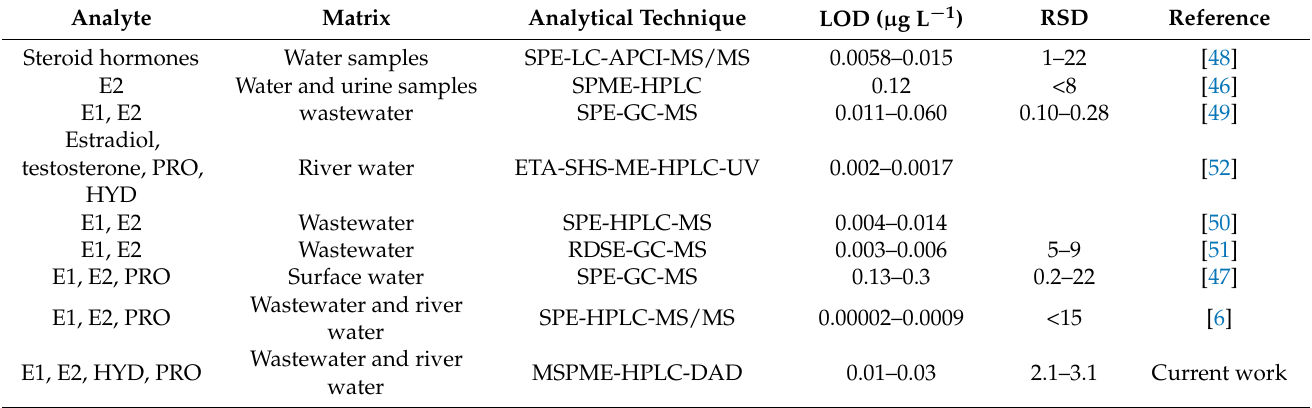
Table 3. Analytical performance comparison between current method and literature-reported methods.